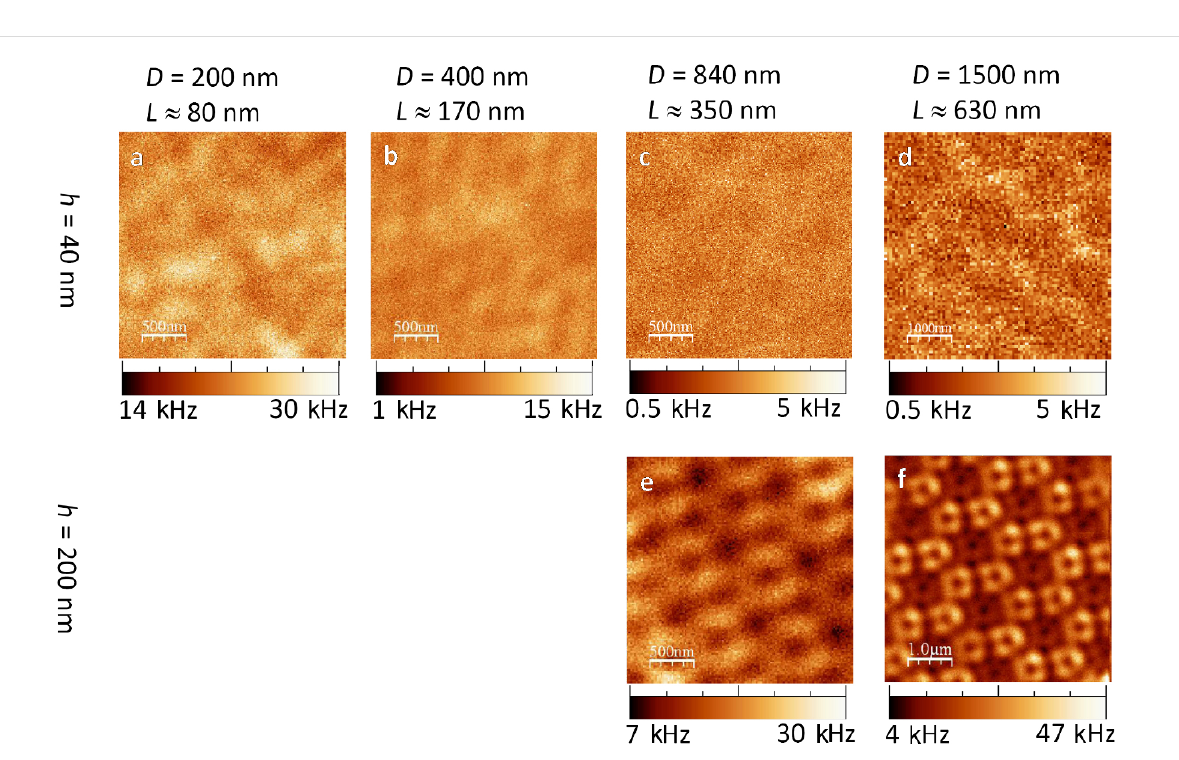
Figure 3: Confocal luminescence images of gold Fischer patterns on a silicon substrate. The images were recorded by scanning the sample through the focus of a radially polarised laser beam . Note the twice as large dimensions of images (d) and (f).